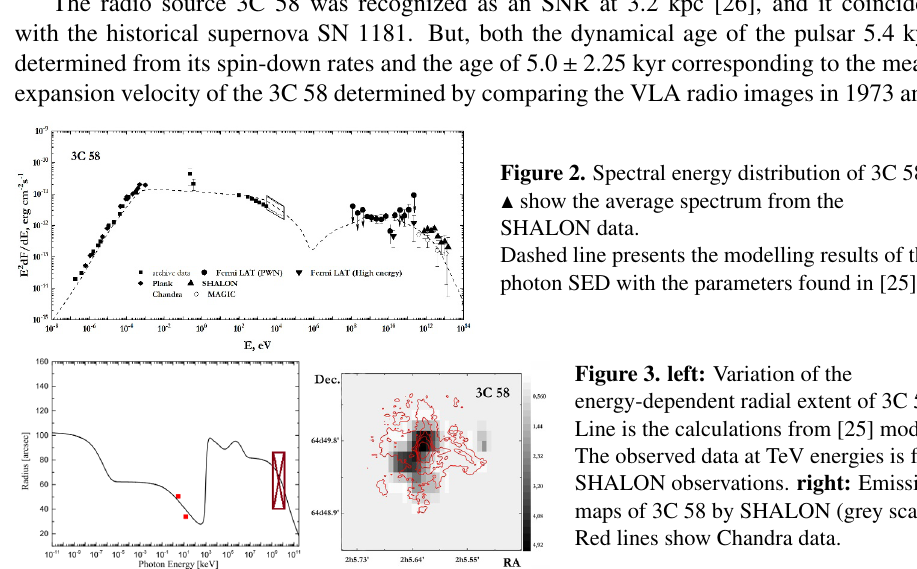
Figure 3. left: Variation of the energy-dependent radial extent of 3C 58. Line is the calculations from [25] model. The observed data at TeV energies is from SHALON observations. right: Emission maps of 3C 58 by SHALON (grey scale). Red lines show Chandra